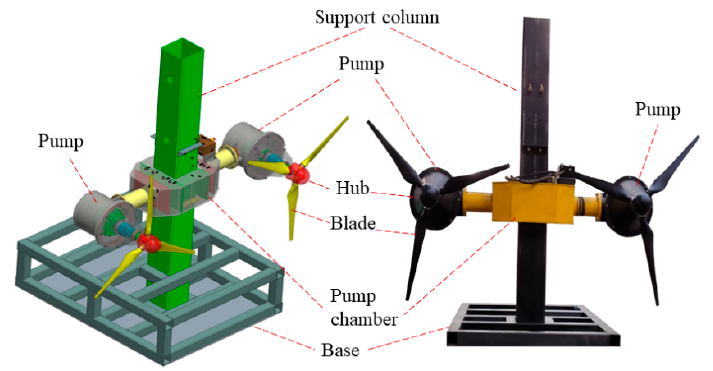
Figure 7. HAMCT overall three-dimensional drawing and assembly structure drawing.